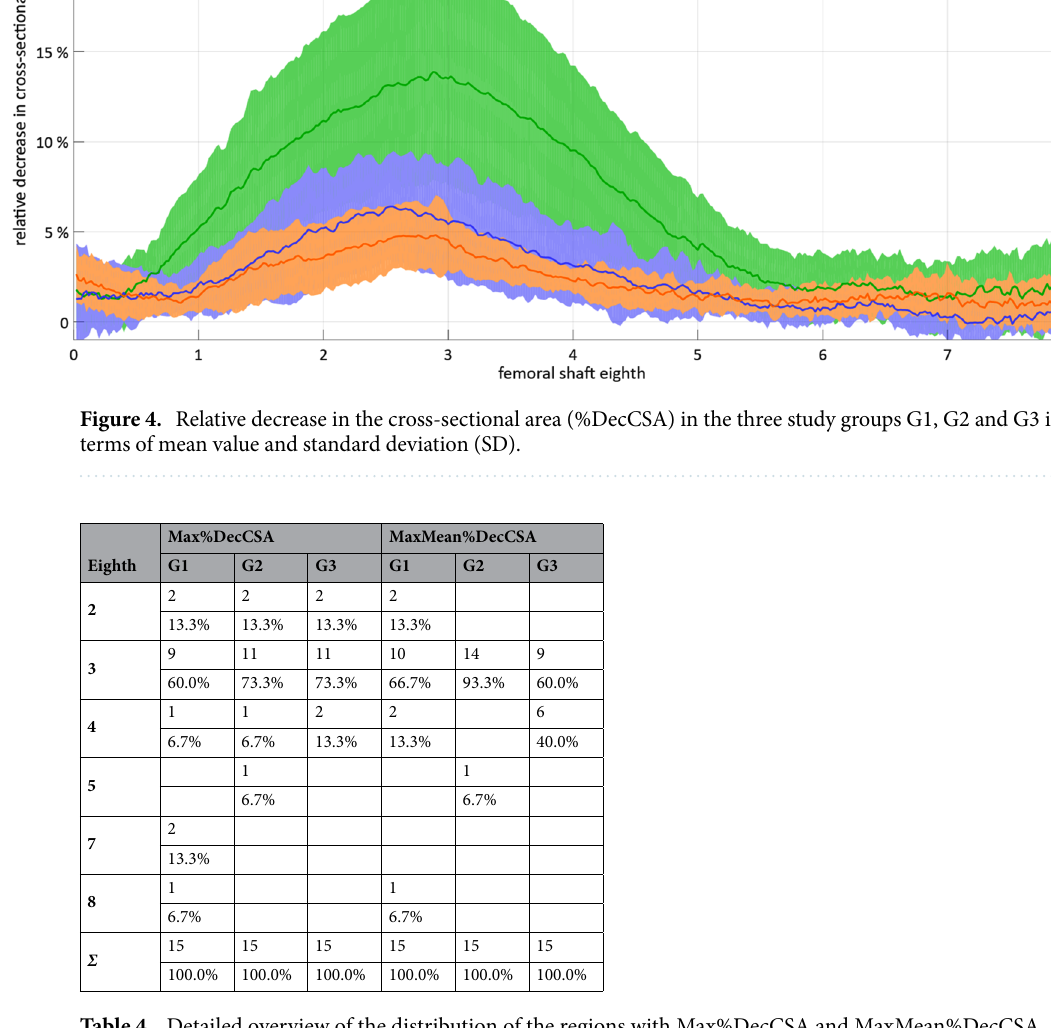
Table 4. Detailed overview of the distribution of the regions with Max%DecCSA and MaxMean%DecCSA among the eights of the femora from the three study groups G1, G2 and